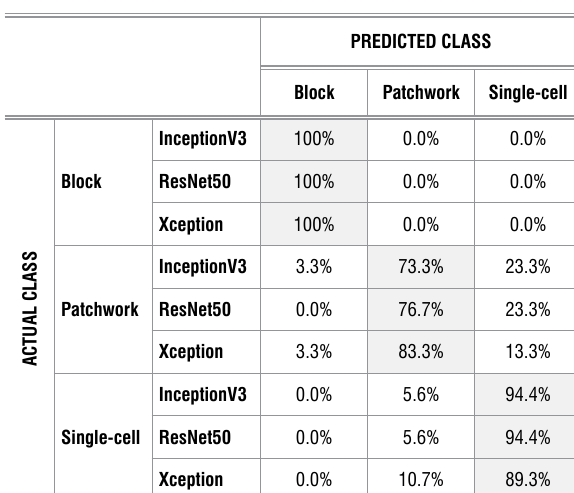
Confusion matrix for the classification task using the original data set. Table cells highlighted in grey indicate correctly classified